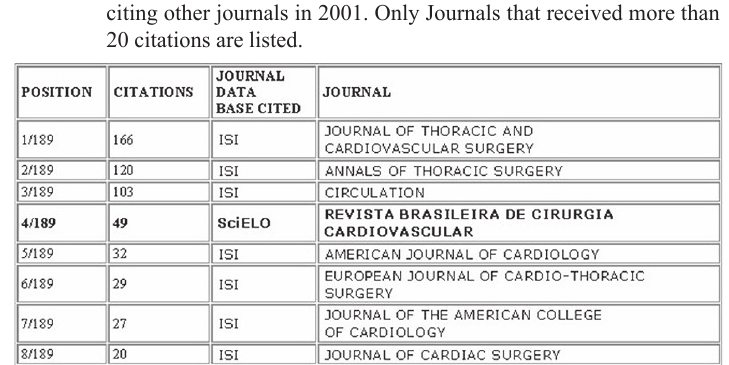
Table 2. REVISTA BRASILEIRA DE CIRURGIA